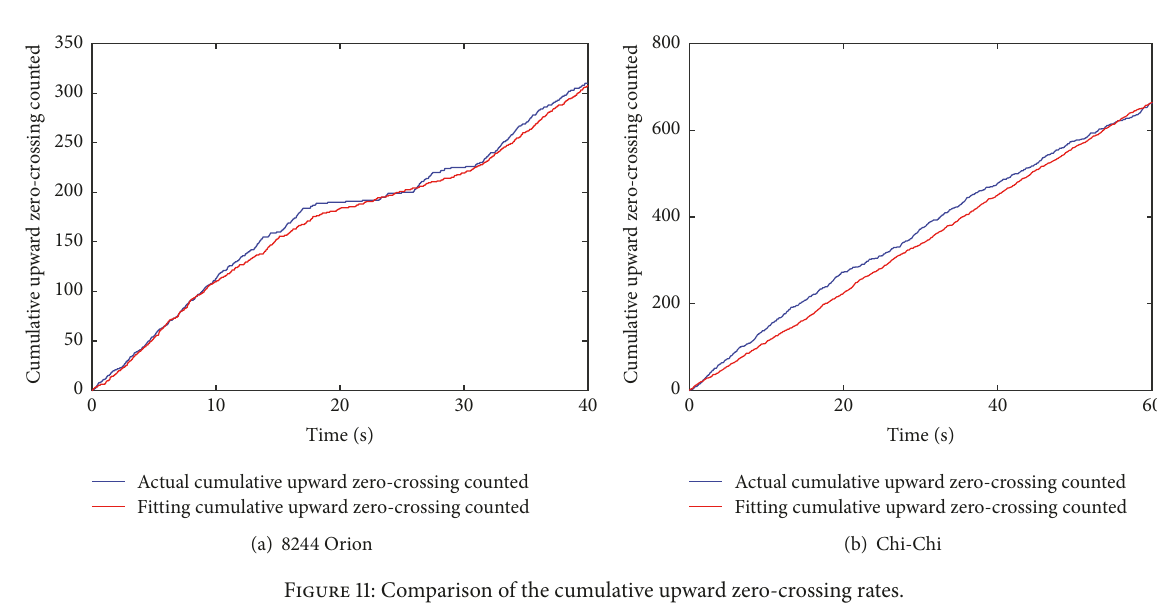
Figure 10: Comparison of the strength envelopes.